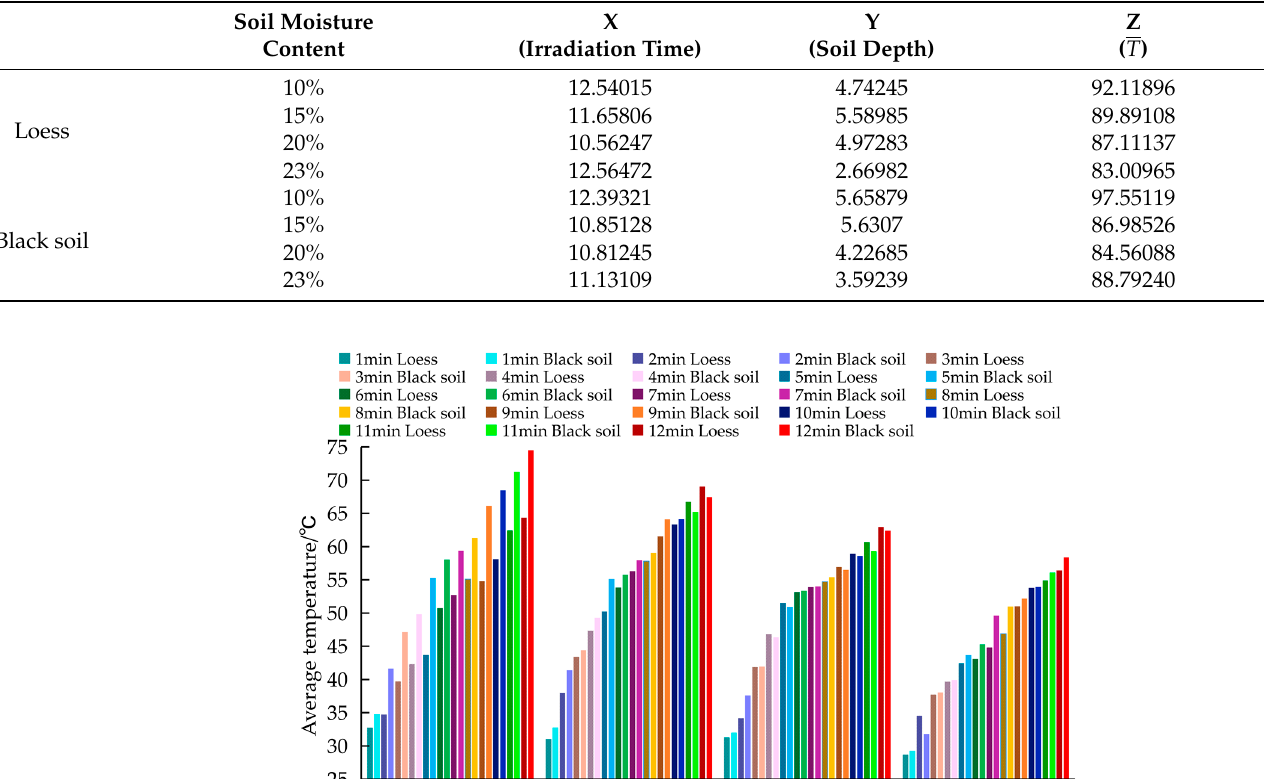
Table 4. The extreme points in the surface equation of the change in the internal temperature of the soil layer with irradiation time and soil depth.